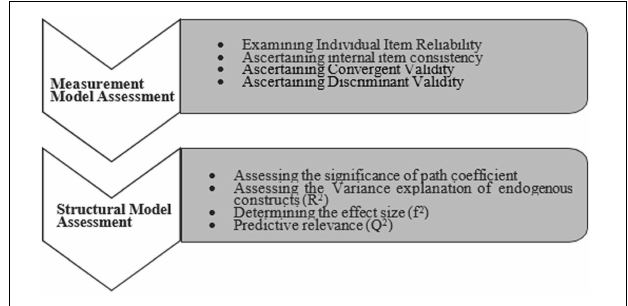
FIGURE 1 | A two-step process of partial least squares (PLS) path model assessment (Henseler et al., 2009).